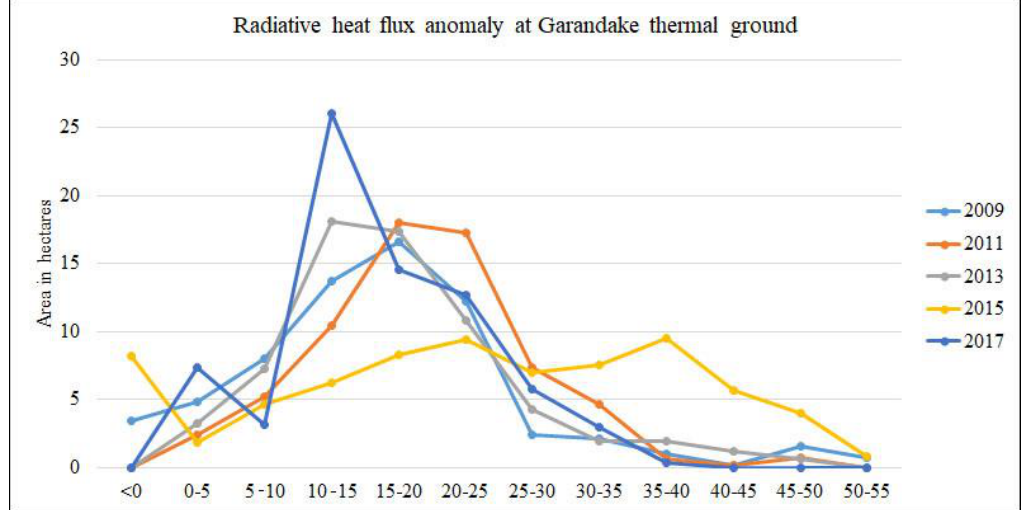
Figure 10. Areas of radiative heat loss anomaly of the Mt. Garan fumaroles from 2009 to 2017, divided naturally into high (above 30 W/m 2 ), middle (10–30 W/m 2 ), and low (less than 10 W/m 2 ) ranges.